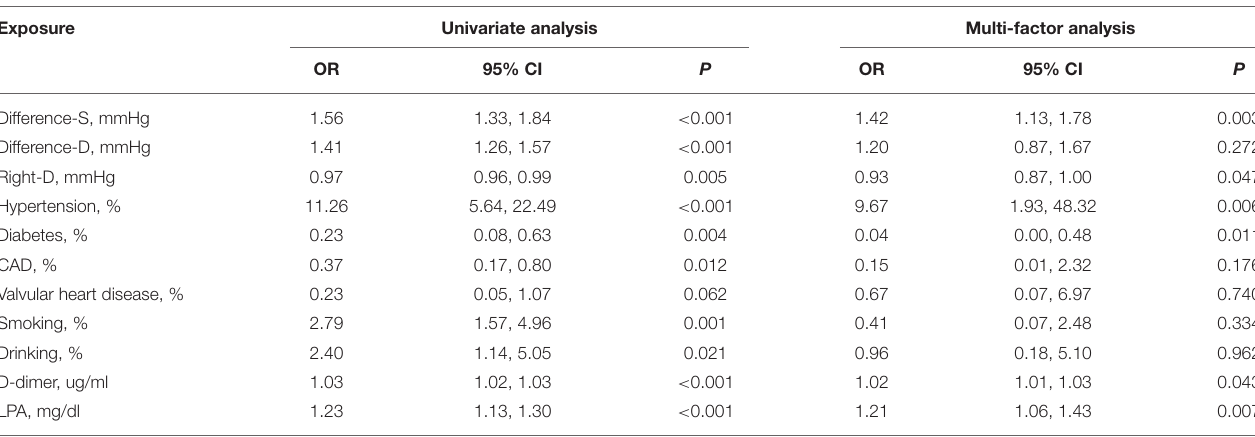
TABLE 2 | Multivariate regression analysis for AAD diagnosis. Exposure Univariate analysis Multi-factor analysis